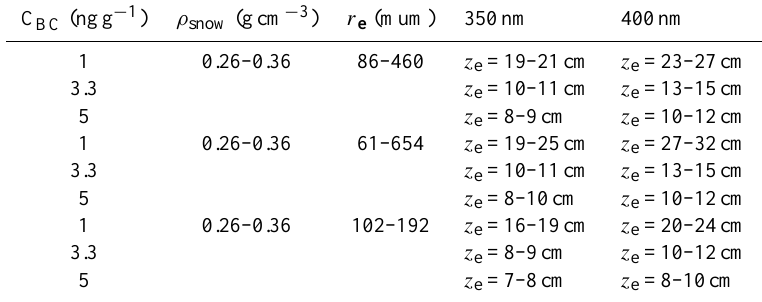
Table D2. e-folding depths calculated for near-station snowpacks at Dome C using vertical density and radiative equivalent ice grain radius profiles from Gallet et al.